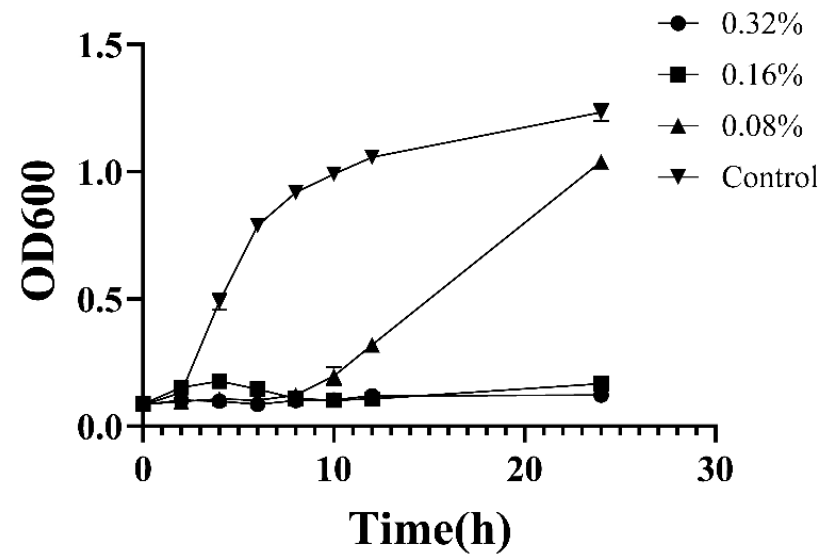
Figure 1. Time–kill curve of MRSA treatment with